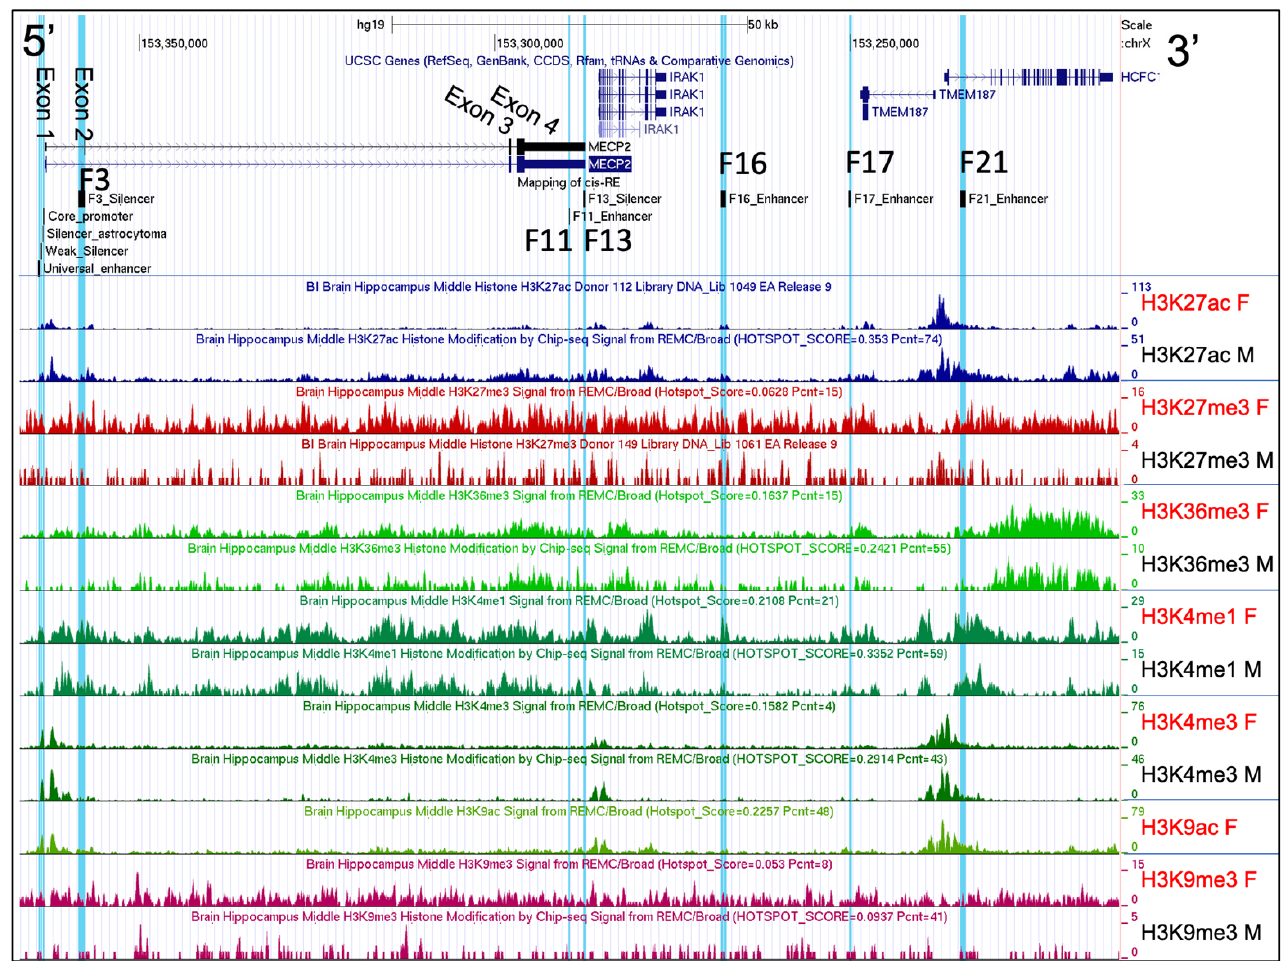
Figure 2. Human Adult Hippocampus histone post-translational modification profiles in males and females. The chrX:153,212,176–153,366,832 genomic region of hg19 human genome assembly is displayed in UCSC genome viewing browser. Direction is 5 ′ –3 ′ (sense orientation relative to the MECP2 gene). Tracks displayed from top to bottom: UCSC genes, mapping of previously identified [55] cis -regulatory elements (REs) (F3-F21) to genome, 13 histone modification CHIP-seq data tracks. M: male, F: female. Cis -REs were highlighted in blue in UCSC. Scale on top represents distance equivalent to 50 kb. MECP2 exons and F regulatory elements are labelled; F regulatory elements are also highlighted in blue. Histone PTMs data are from GSE17312. The donors selected were: #112 (75 Y, female, disease-free, Rush University Medical Center), and #149 (81 Y, male, disease-free, Rush University Medical Center).